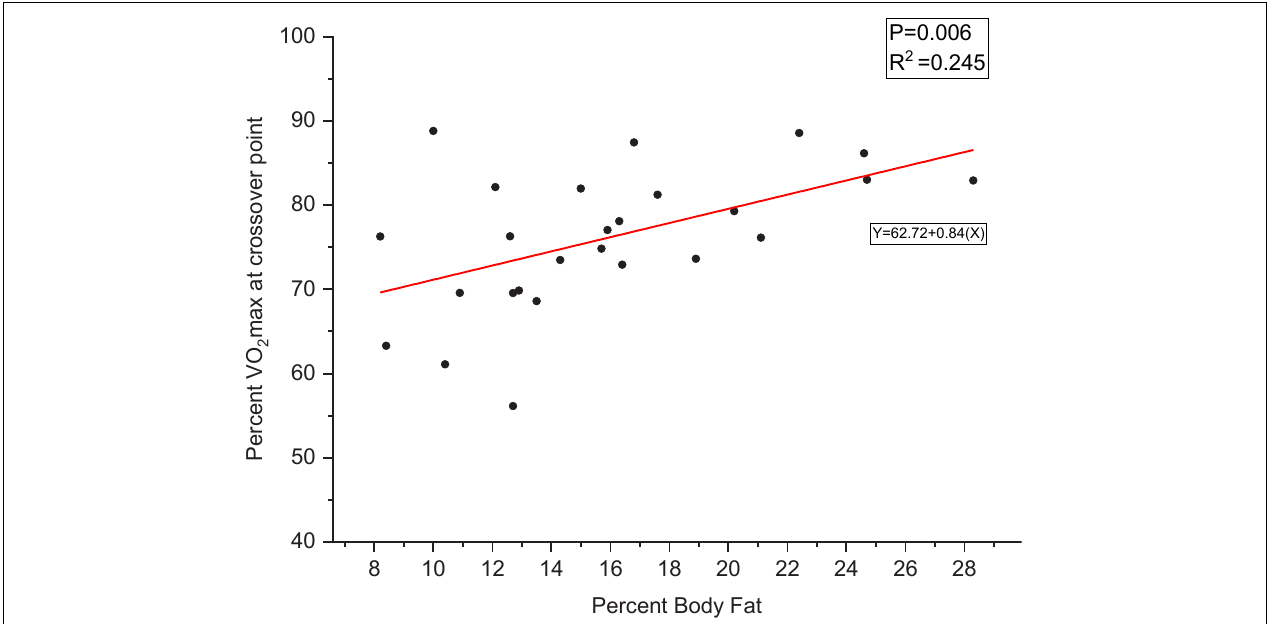
FIGURE 2 | Relationship between percent maximal oxygen consumption (VO 2 max) at crossover point and percent body fat during the maximal graded exercise test (MGET) established by linear regression. P = 0.006, significant relationship between a higher percent body fat and lipid utilization as the primary substrate (e.g., delays crossover to using carbohydrate). The red line is the regression line expressing the hypothesized relationship between percent VO 2 max at crossover point and percent body